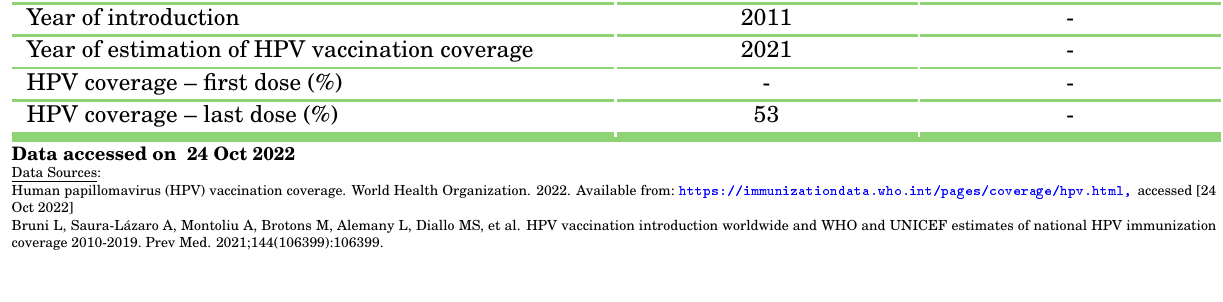
Figure 71: HPV vaccination coverage in females by year in